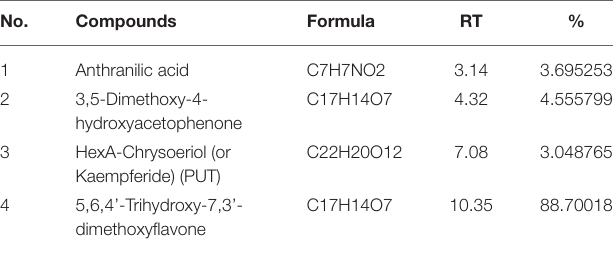
TABLE 6 | Major compounds identified in barley bran aqueous/methanol extract using the LC-MS